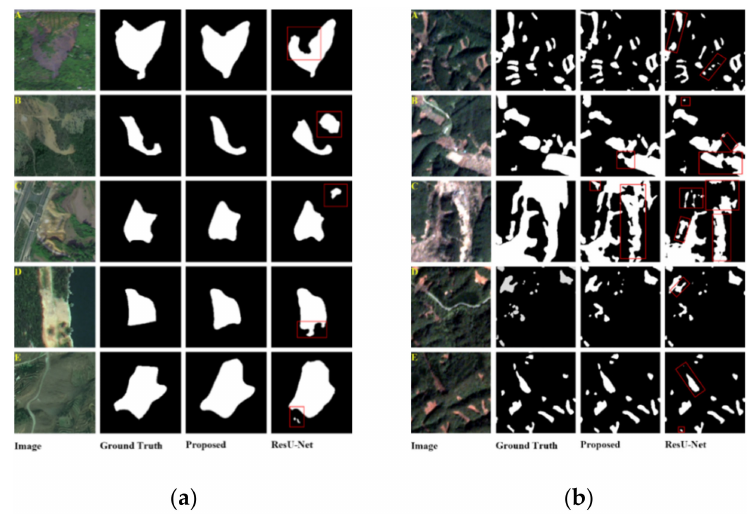
Figure 7. The result comparison of two models in the Bijie dataset ( a ) and the Iburi dataset ( b ). Black color represents the background, white color represents the landslide area. Red polygons show the areas that were not fully identified by the two models. A–D are images randomly selected from the testing samples for visual comparison.